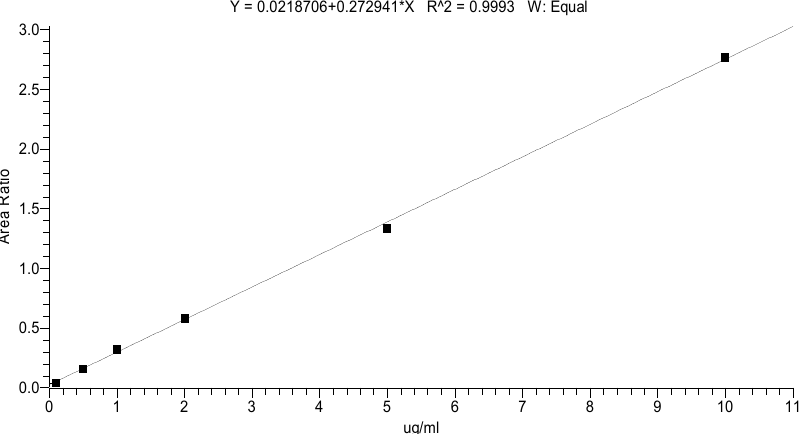
Figure 7. Standard curve. A correlation curve of concentration of the reference peptide and area ratio of the reference peptide and internal reference